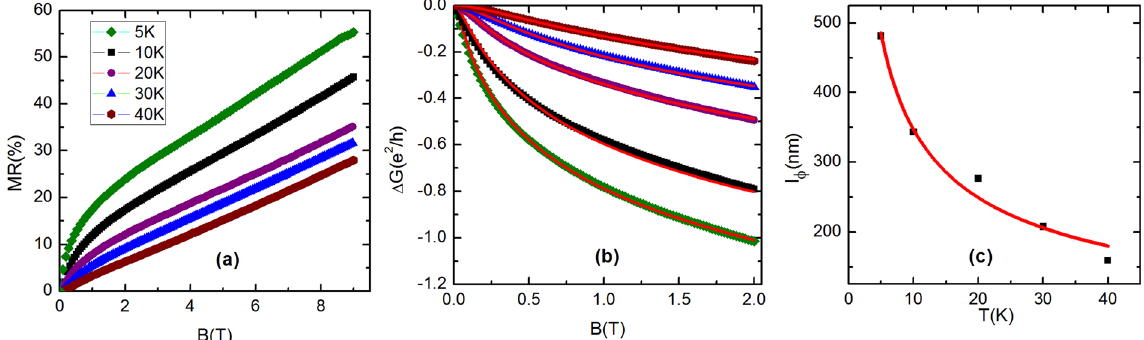
Figure 2. ( a ) Magnetic field dependence of the magnetoresistance (MR) for the S2 crystal at different representative temperatures between 5 and 40 K. ( b ) Field dependence of the surface conductance ( G ), which has been calculated using the expression, = ρ . Here, ρ xy is the Hall resistivity and t is the thickness of G t xx 2 2 ρ ρ + xx xy the sample. Solid lines are the fit to the experimental data with HLN equation (mentioned in the text). ( c ) Dephasing length is plotted against temperature, which follows the expected T − 0.5 dependence, as shown by the red